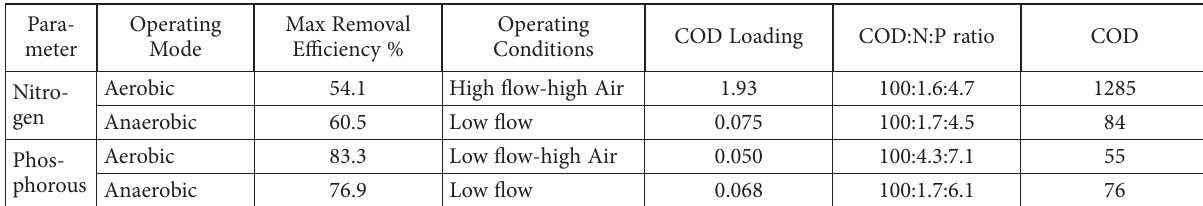
Table 3. Overview of nutrient removal